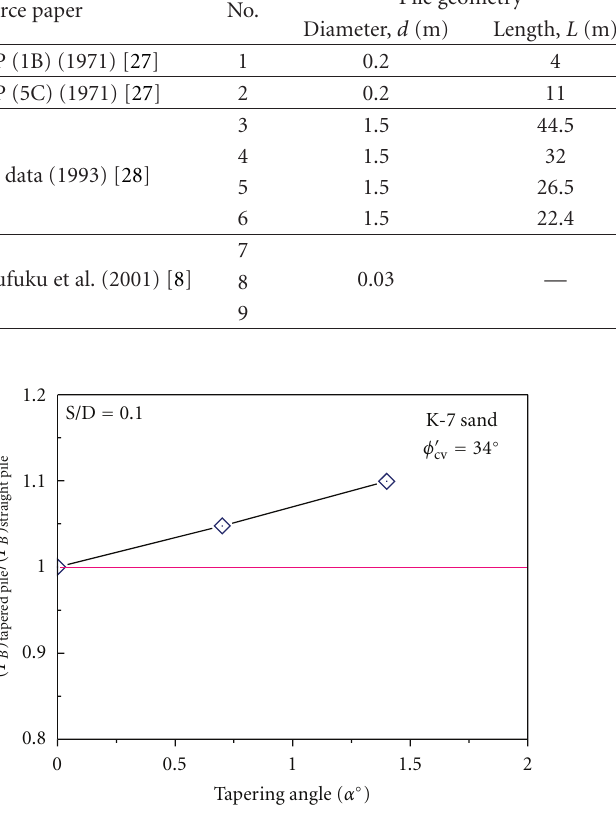
Figure 7: Normalized end-bearing capacity of K-7 sand at di ff erent pile tapering angles.